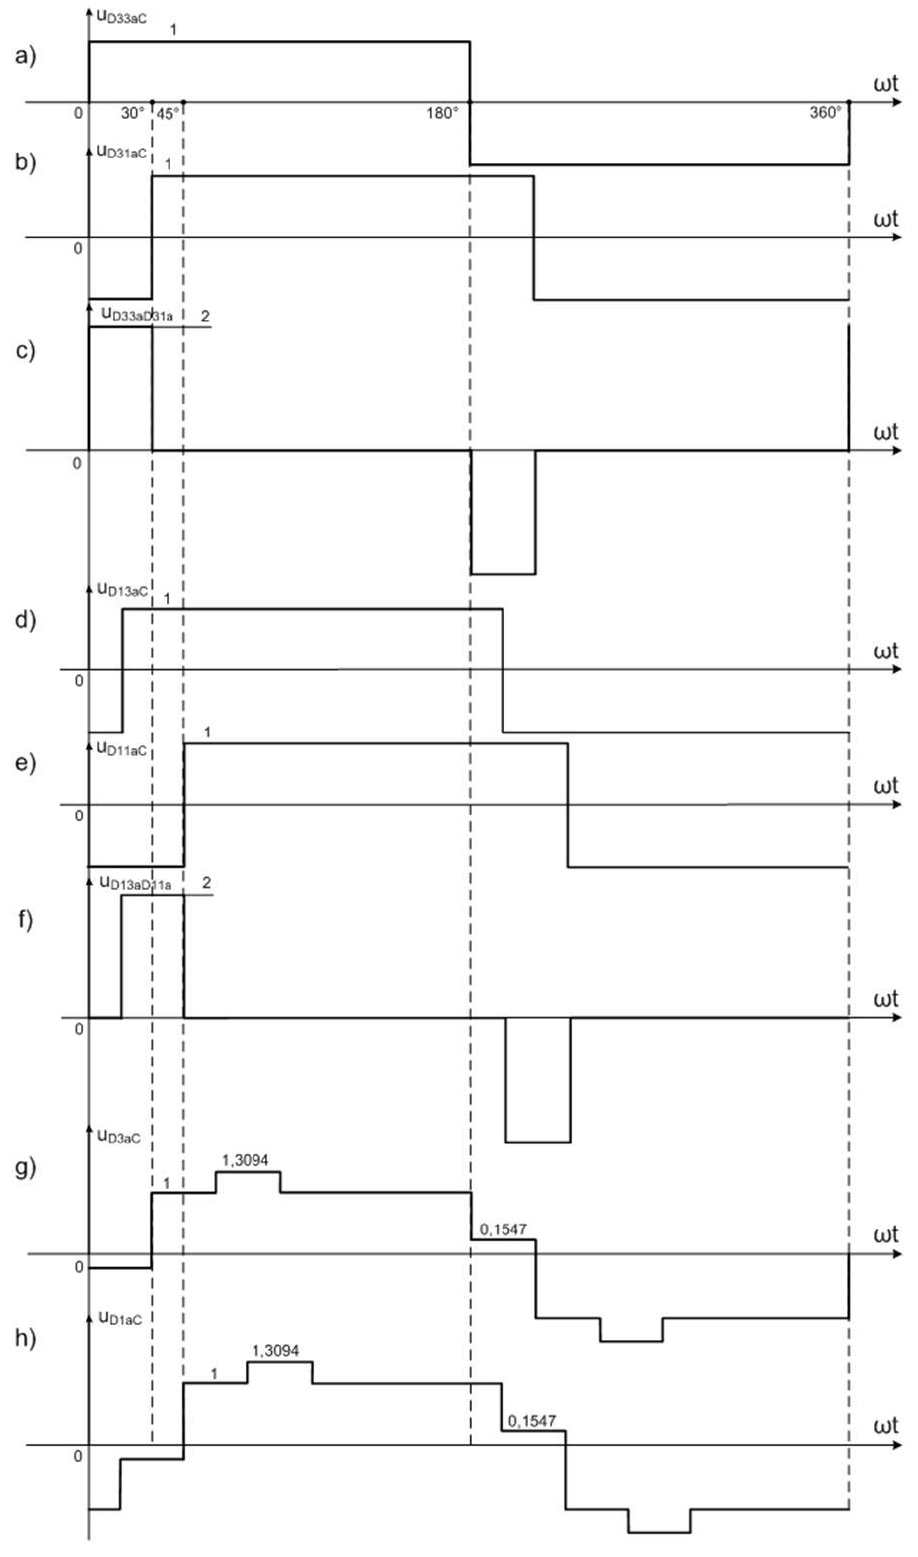
Figure 14. Phase voltage waveforms u D 33 aC , u D 31 aC , u D 13 aC , u D 11 aC , u D 3 aC , u D 1 aC and u D 13 sD 11 s = u D 13 sC − u D 11 sC , u D 33 sD 31 s = u D 33 sC − u D 31 sC